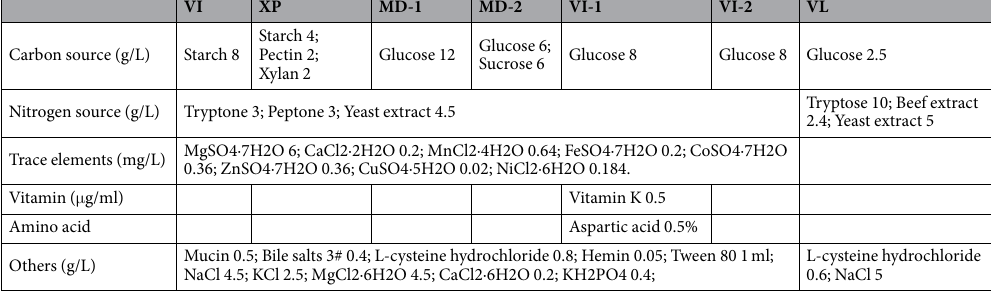
Table 2. Components of the culture media used in this